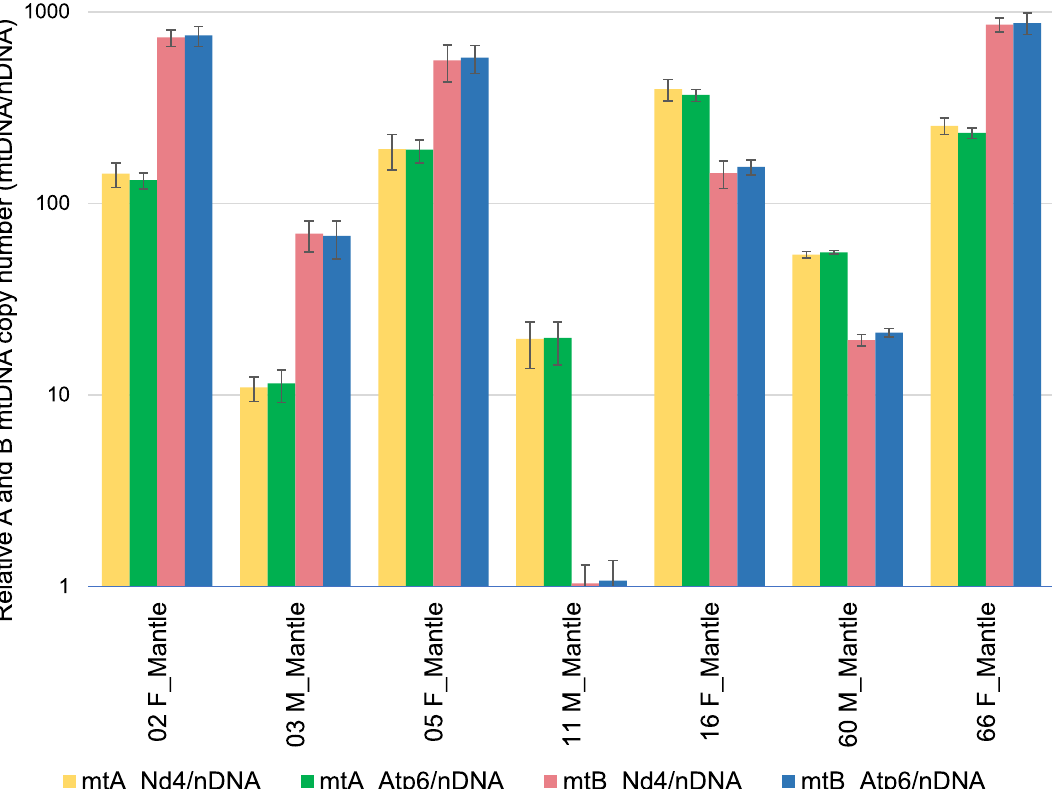
Figure 2. The ratio of mtDNA to nDNA in seven heteroplasmic individuals of B. pharaonis. F represents female individuals; M represents male individuals. The yellow and green colored bars represent sequence copy number per nuclear DNA for type A mtDNA; The pink and blue bars represent sequence copy number per nuclear DNA for type B mtDNA. The target genes atp6 and nd4 are located on the opposite sites of the respective mitogenomes separated by repetitive sequences. Samples described as “Mantle” contained mainly gonadal tissues, not just the somatic